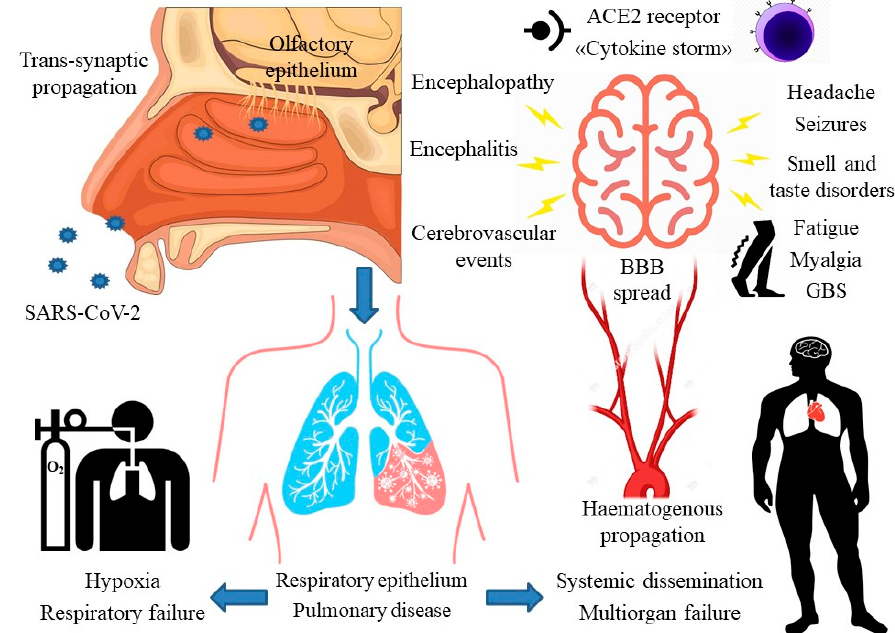
Figure 1. Main neurological manifestations of COVID-19 and proposed mechanisms of SARS-CoV-2 neuroinvasion. ACE2: angiotensin II converting enzyme receptor-2; BBB: blood-brain barrier; GBS: Guillain-Barré syndrome.